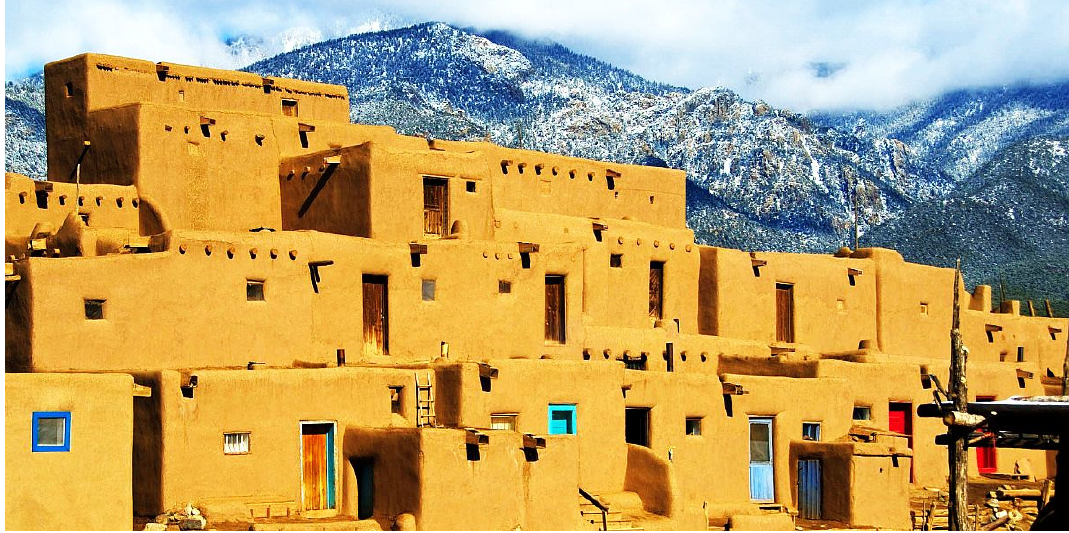
Figure 4 . Ancient unstabilised adobe dwellings inhabited by a native American tribe of about 150 people at Taos Pueblo in New Mexico (USA).